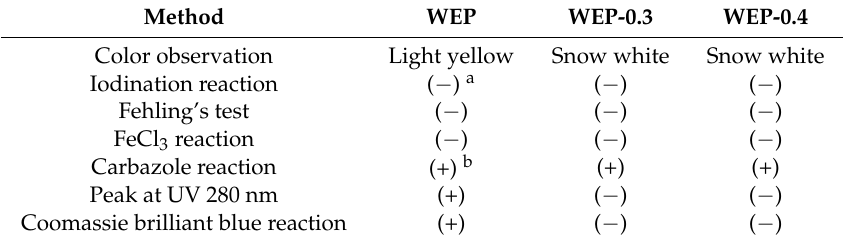
Table 1. Comparison of physicochemical properties of WEP and its fractions (WEP-0.3 and